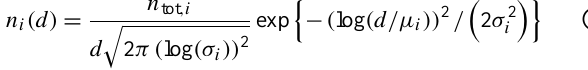
Fig. 3. Histograms of vertical velocity w , pressure p and temper- ature T in the sample set used for constructing the approximation error samples. N denotes the number of